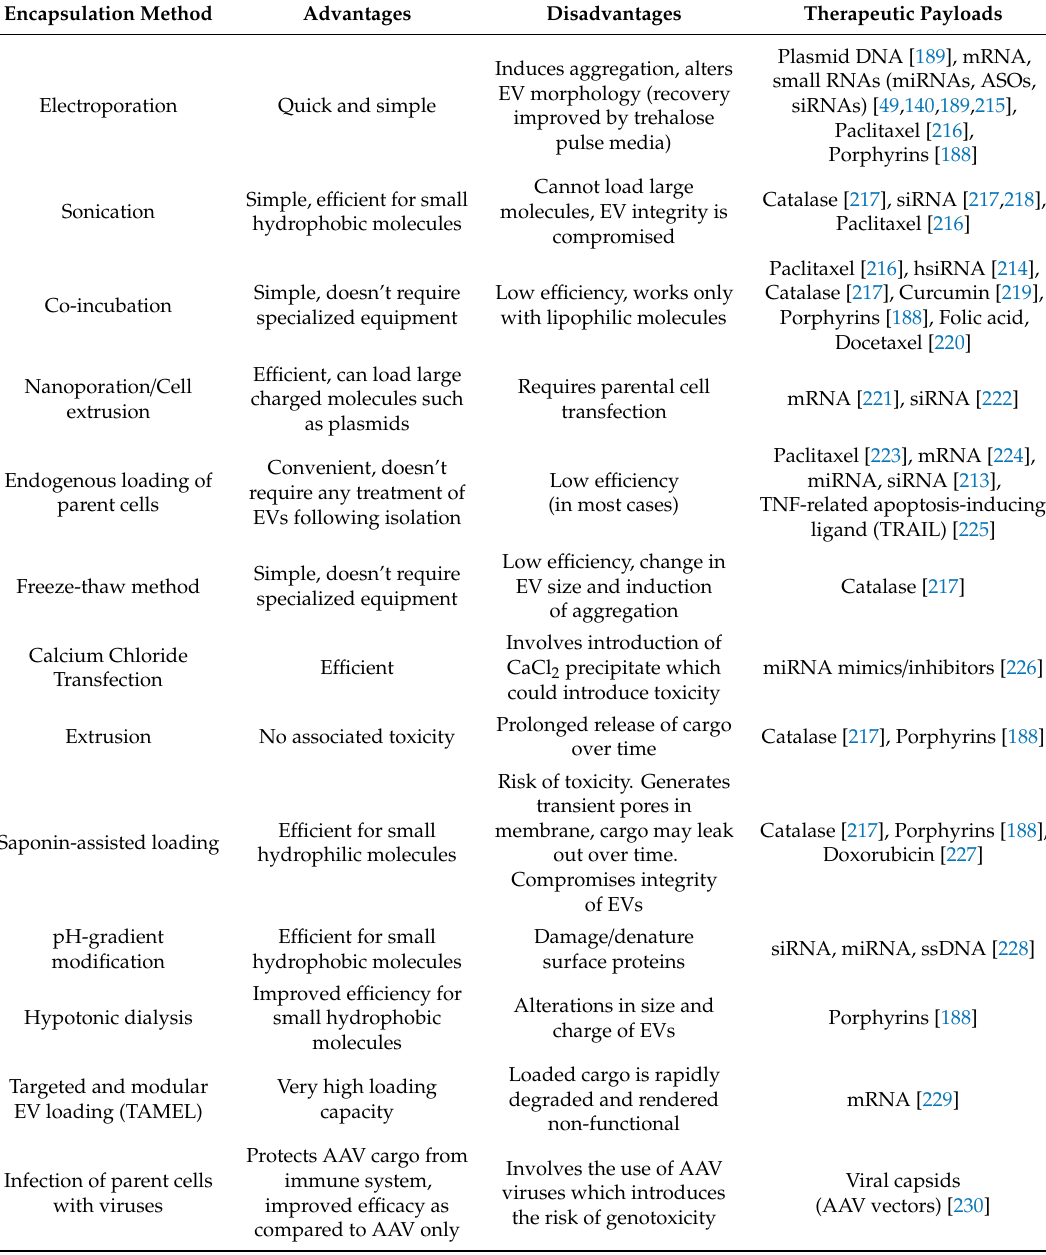
Table 1. Strategies used for loading EVs with di ff erent types of therapeutic molecules along with associated advantages and